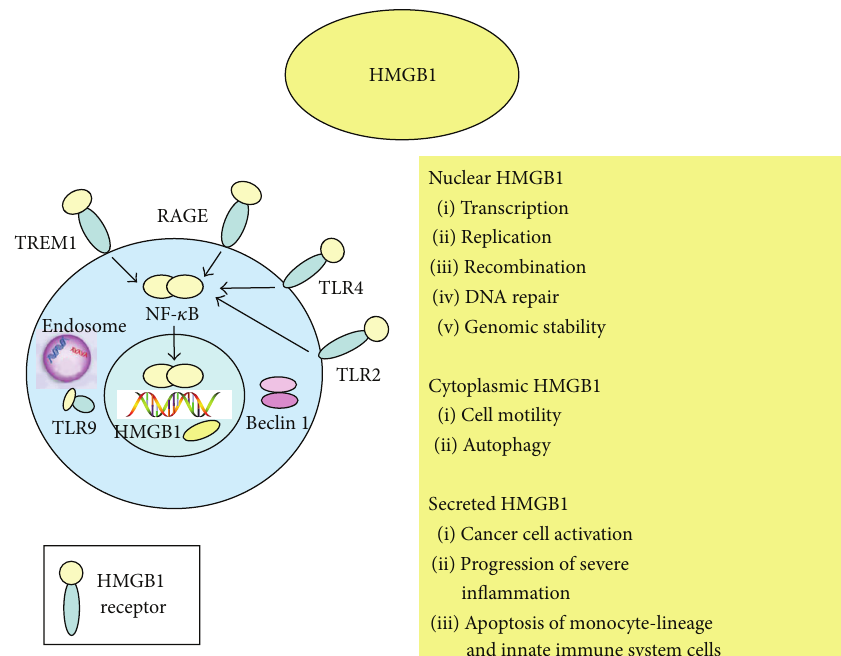
Figure 1: Functions of high mobility group protein B1 (HMGB1). HMGB1 modulates inflammation, immunity, chemotaxis, and tissue regeneration. HMGB1 leads to NF- 𝜅 B activation that in turn can upregulate inflammatory cytokine production, HMGB1 secretion, and HMGB1 receptor expression (TRL2, TRL24, RAGE, TRL9, and TREM1). HMGB1 participates in DNA replication, recombination, transcription, and repair. HMGB1 interacts with TLR9 in the endoplasmic reticulum-Golgi intermediate compartment. HMGB1 promotes autophagy. Cytosolic HMGB1 binds to Beclin-1 which promotes autophagosome formation and dynamic intracellular trafficking during